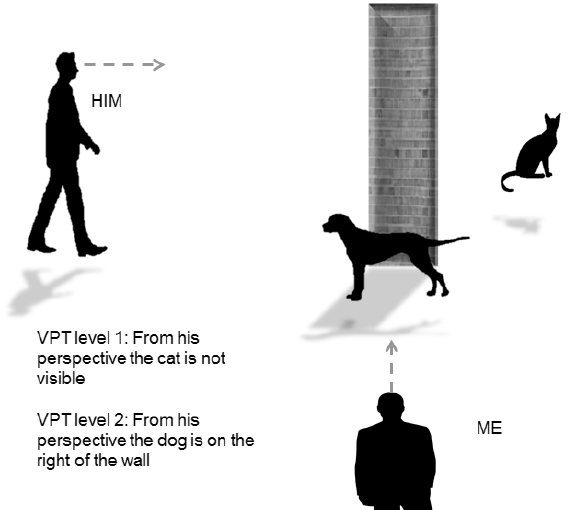
Figure 7. Visual Perspective Taking (VPT) level 1 and Visual Perspective Taking (VPT) level 2.